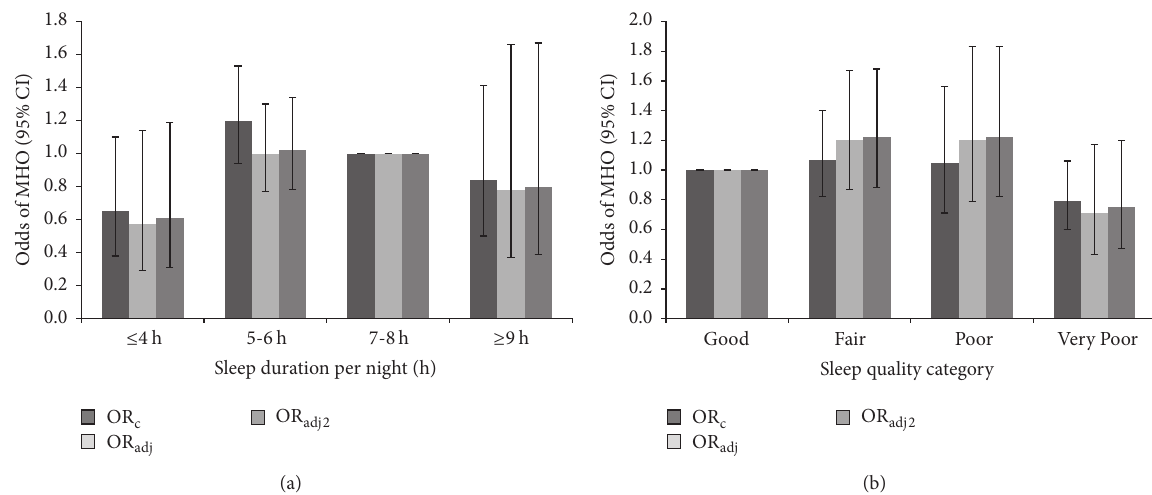
Figure 1: The odds of metabolically healthy obesity by sleep duration (a) and sleep quality (b) categories. Modeled for MHO (i.e., absence of metabolic syndrome according to the Joint Interim Statement, ≤ 2 cardiometabolic dysfunctions). Responses to sleep quality habit questions were summed to obtain the overall sleep quality, which were categorized as good (0 to < 3); fair (3 to < 7); poor (7 to < 12); and very poor ( ≥ 12 to 24). OR is crude, OR adjusted for age, sex, ethnicity, education, income, smoking, alcohol, and leisure-time physical activity, and OR c adj additionally adjusted for physician diagnosed sleep disorder. MHO is metabolically healthy obesity in people with BMI of ≥ 30 kg/m 2 . All models were not